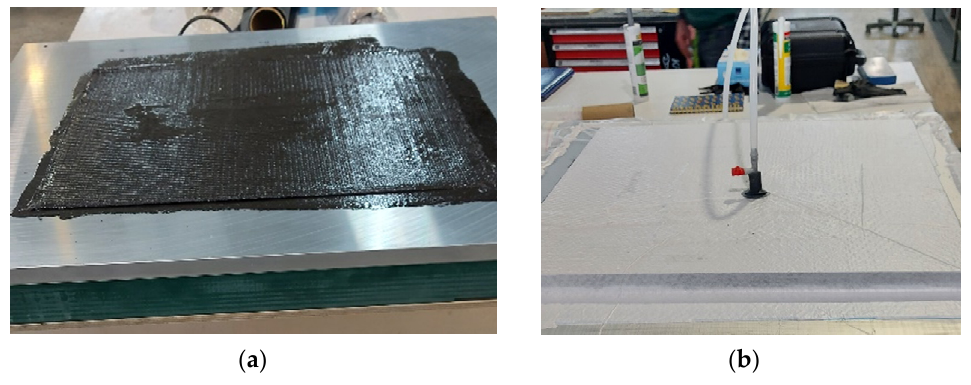
Figure 1. Composite lamination ( a ) with vacuum support ( b ).